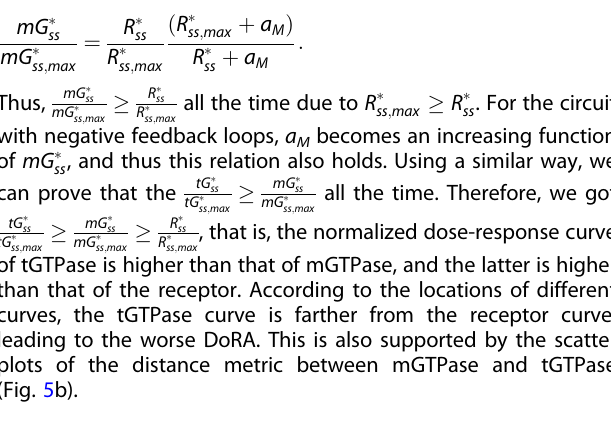
Fig. 4 The OR logic gate has the similar DoRA behavior to the AND logic gate. a Comparisons of the distance metrics between the system with the AND logic gate and that with the OR logic gate. The AND logic gate means that the production rate of mGAP is modeled by k AND tGEF (cid:6) tG (cid:1) ; the OR logic gate corresponds to k OR tGEF þ tG (cid:1) Þ . Each dot corresponds to one kinetic parameter set in the parameter feedback (cid:6) feedback ð ; k mG ; k tG space f k R is different from k AND to ensure the same mGTPase activation level mG (cid:1) g , and the k OR on on on feedback feedback stimulus S → ∞ ). The black dashed line indicates the averaged distance from dots to the diagonal line. The diagonal line is in blue. b Theoretical analysis for comparisons of distance metrics between AND and OR logic gates in the mass action model. The tGEF can be rewritten as a function of mG * , i.e., h 1 ( mG * ); the tG * is rewritten as the function h 2 ( mG * ). c , d The same plots as in ( a – b ) but the Hill-function kinetics is